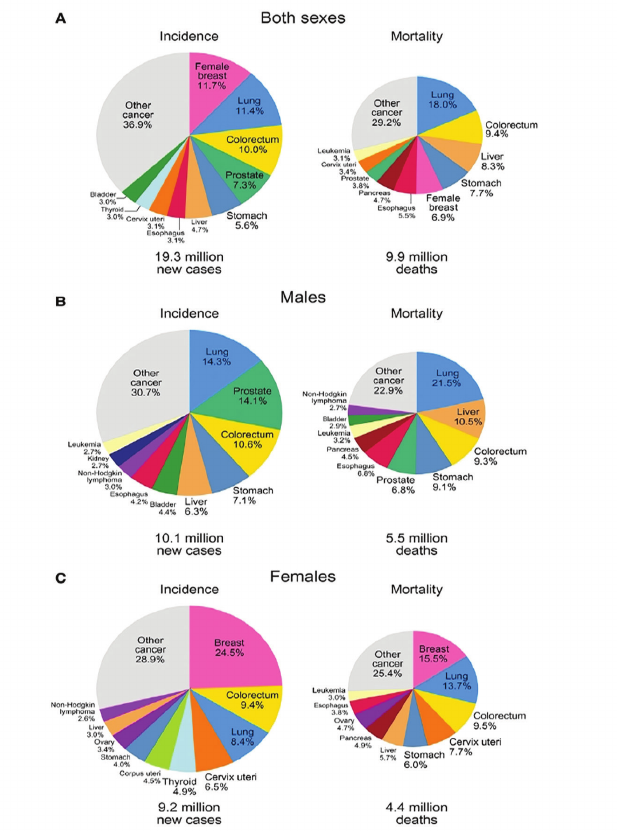
Figure 1 - Global cancer statistics 2020: GLOBOCAN estimates of incidence and mortality worldwide for 36 cancers in 185 countries (https://acsjournals.onlinelibrary.wiley.com/doi/10.3322/ caac.21660#:~:text=Worldwide%2C%20an%20estimated%20